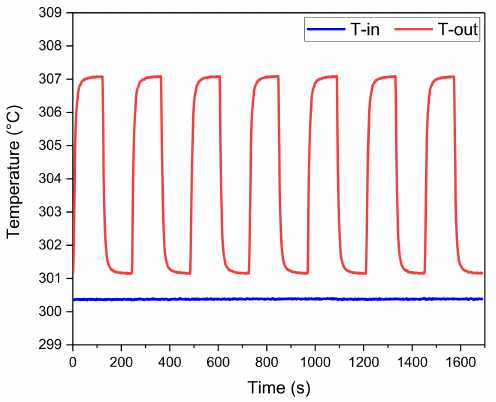
Figure 15. Temperatures (T-in and T-out) in 7 short cycles for ODS mock-up run 9 September 2019.